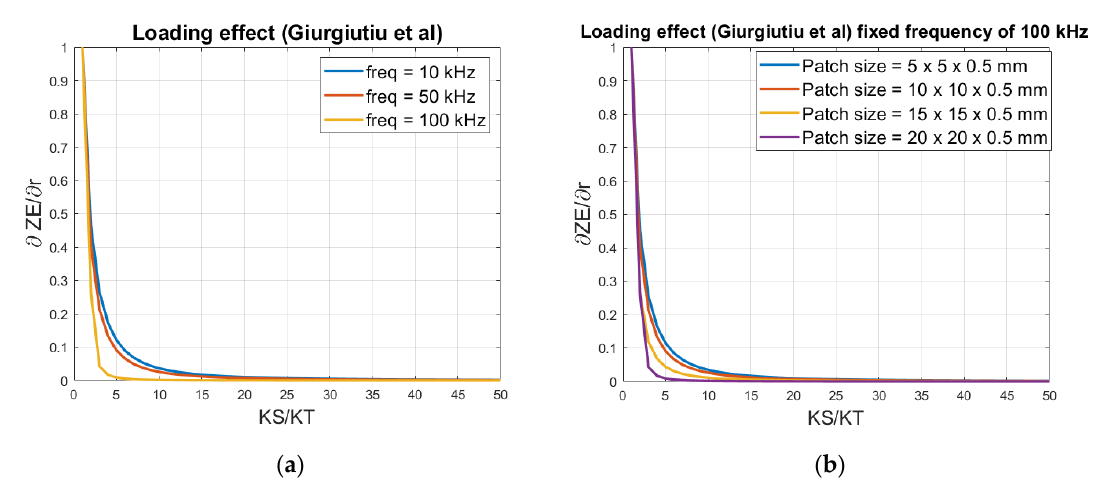
Figure 4. Normalized derived of the impedance as function of the loading regarding ( a ) frequency impact, and ( b ) size